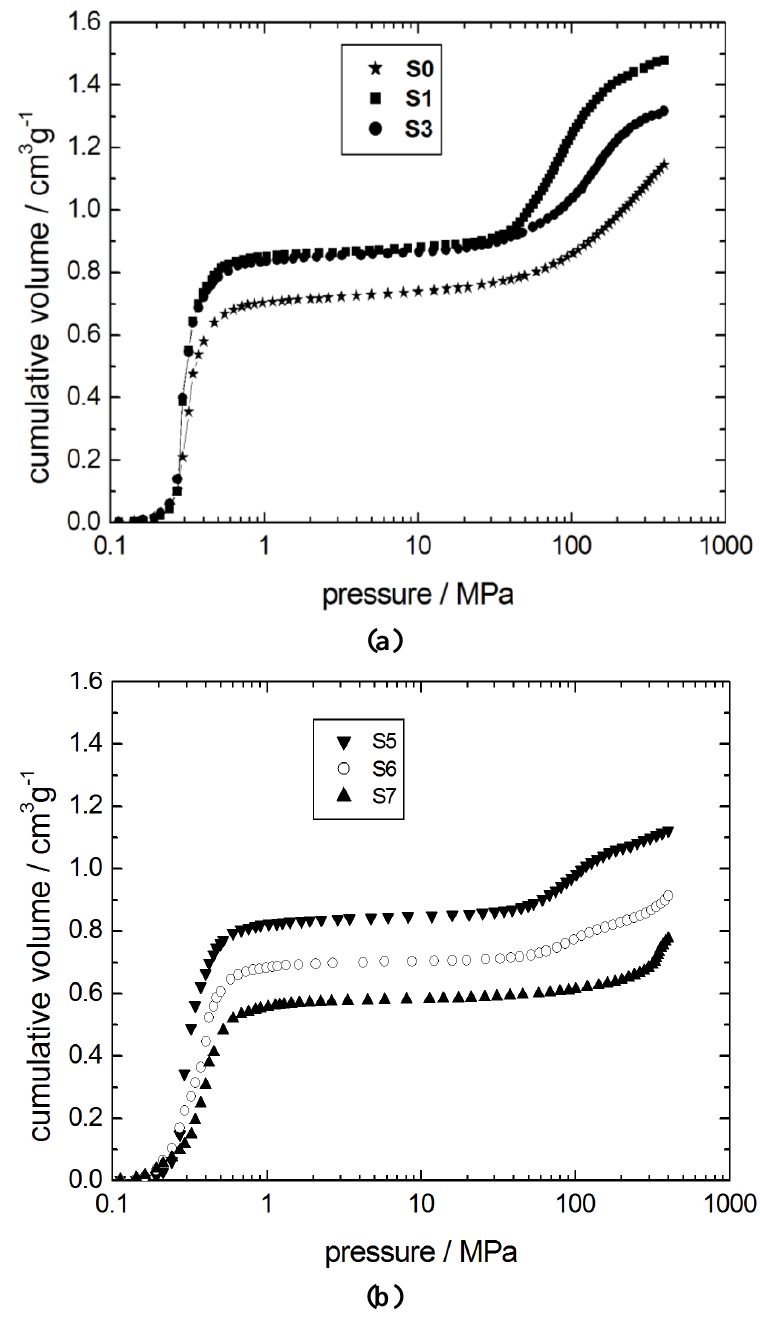
Figure 3. Mercury intrusion curves for the initial silica gel S0 and the transformation products ( a ) S1, S3; and ( b )